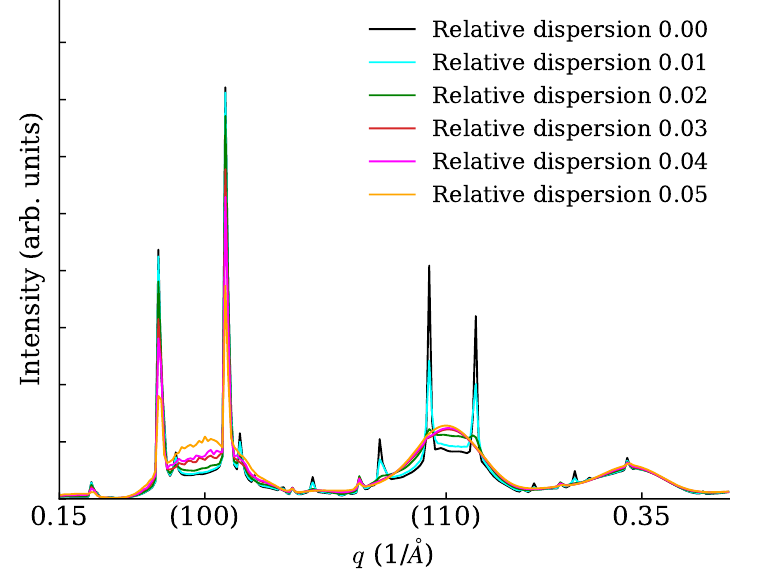
Figure 8. XRPD scattering from a plate (2D SC) with various levels of relative SL spacing dispersion, approximately the same as in Figure 6 but evaluated by brute